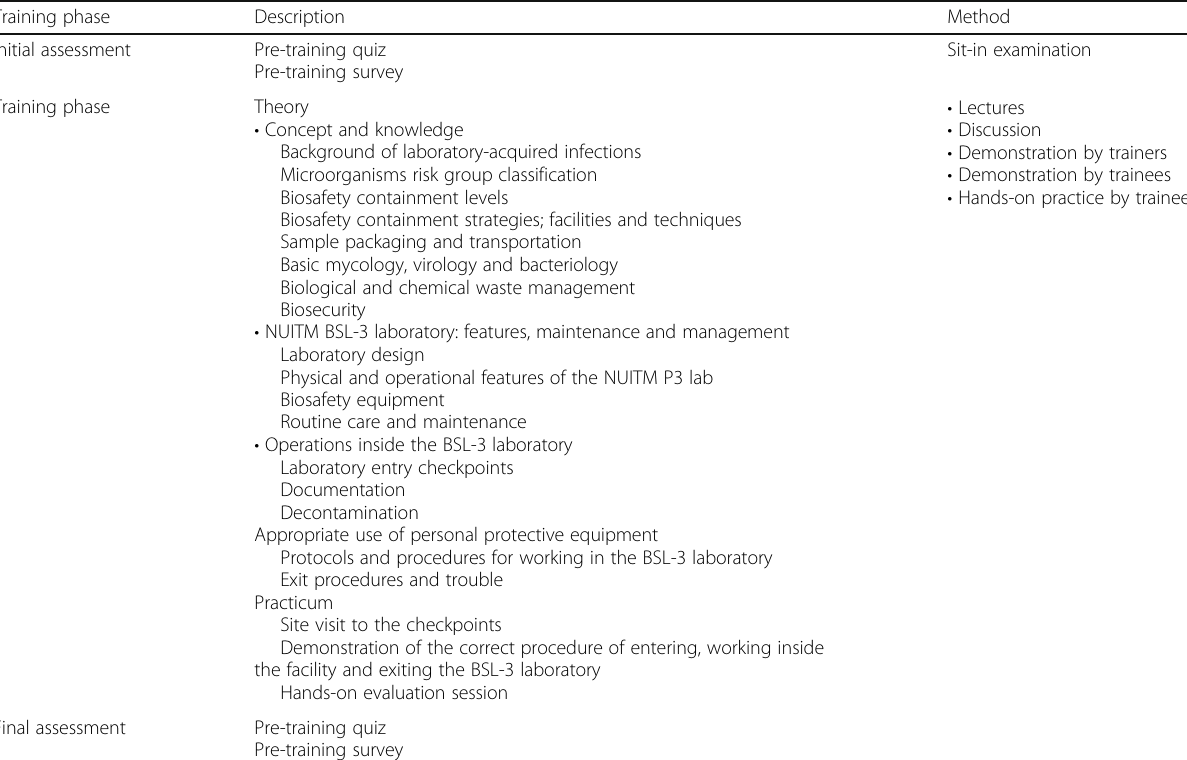
Table 1 Training program